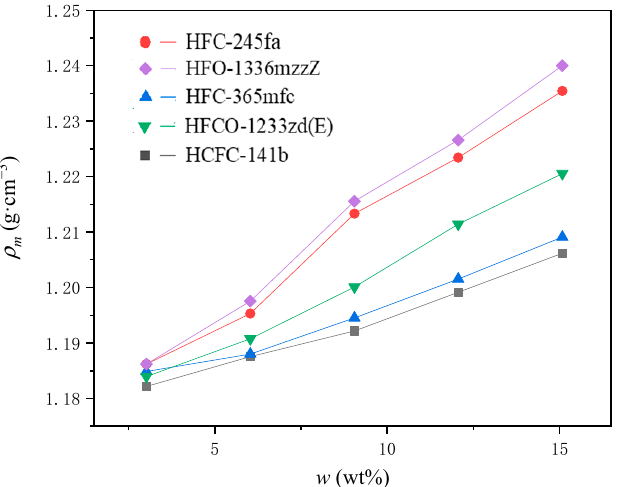
Figure 4. The relationship of the density of polyurethane mixtures with different PBAs, ρ m , and the initial mass ratio of the PBA to the other blending materials in the PURF, w .